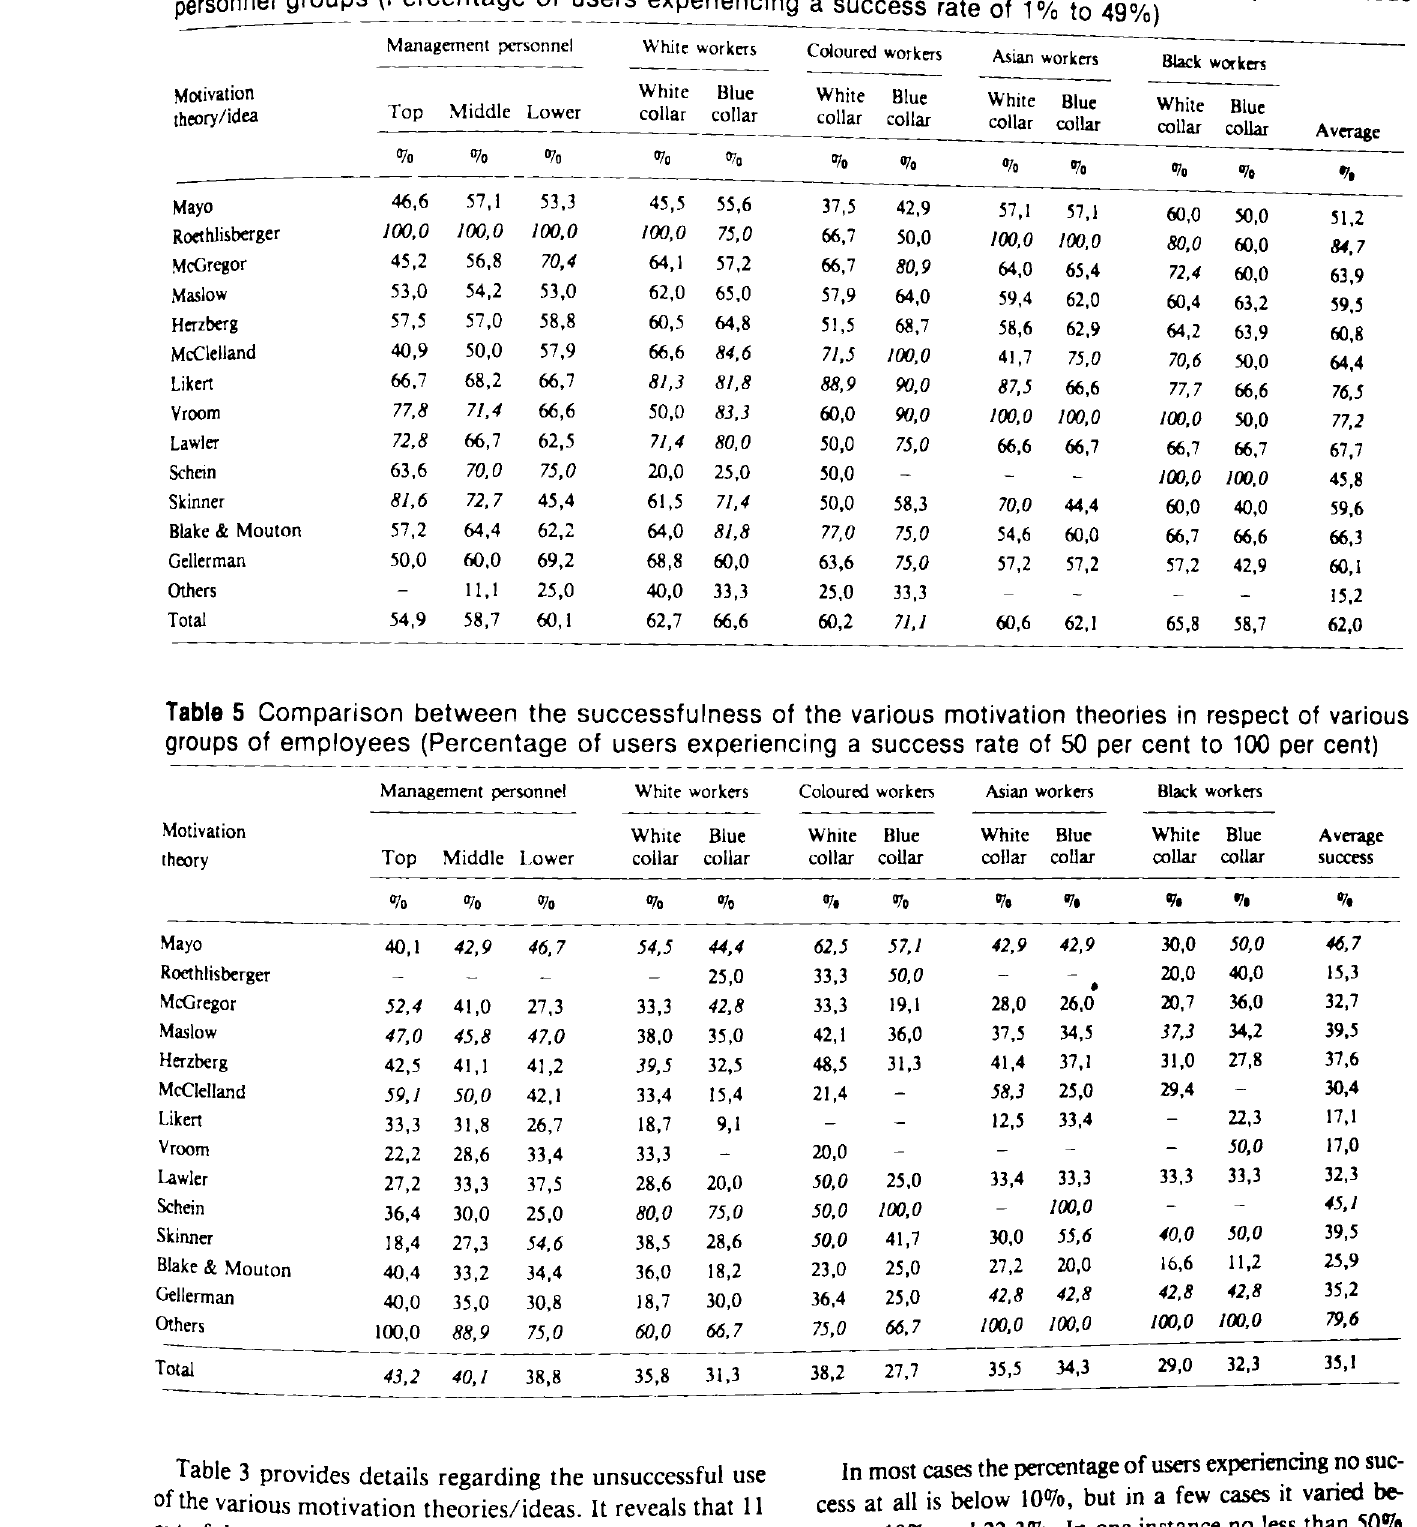
Table 5 Comparison between the successfulness of the various motivation theories in respect of various groups of employees (Percentage of users experiencing a success rate of 50 per cent to 100 per